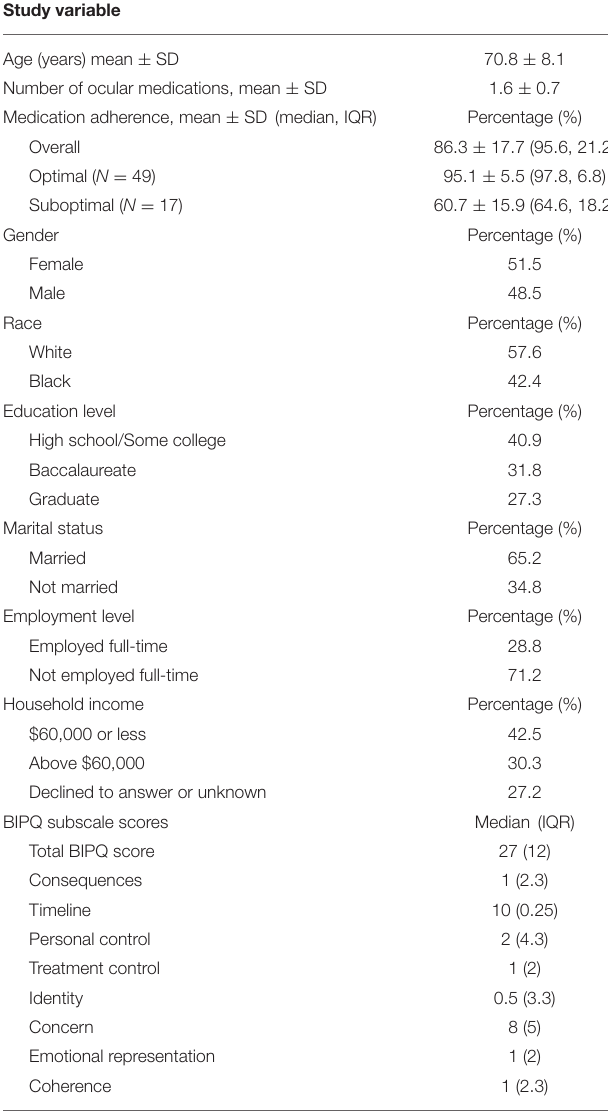
TABLE 1 | Participants clinical, demographic, and psychological characteristics. Study